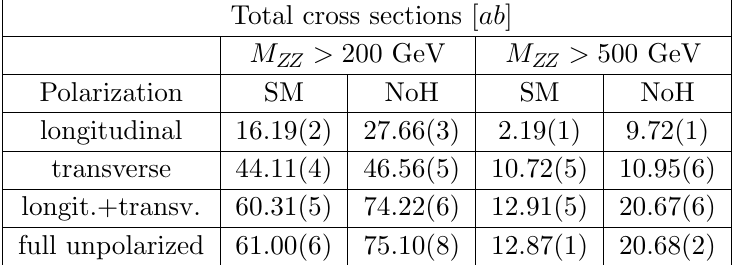
Table 16 . SM and Higgsless total cross sections ( ab ) for ZZ scattering, in the whole (cid:12)ducial region and for M ZZ > 500 GeV.